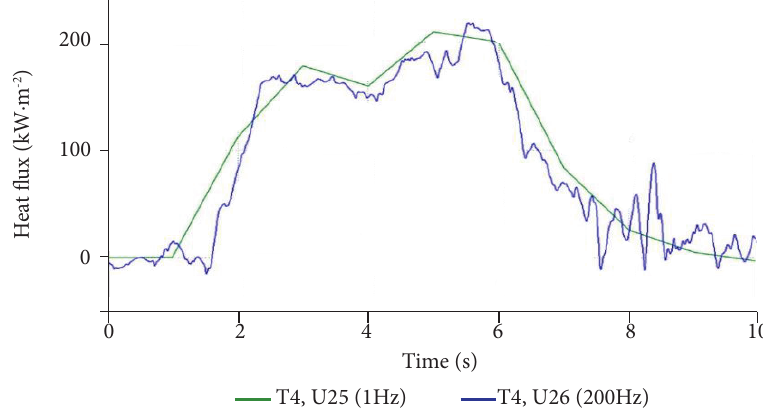
Figure 13. Heat flux from temperature history of thermocouple T4, U25 and